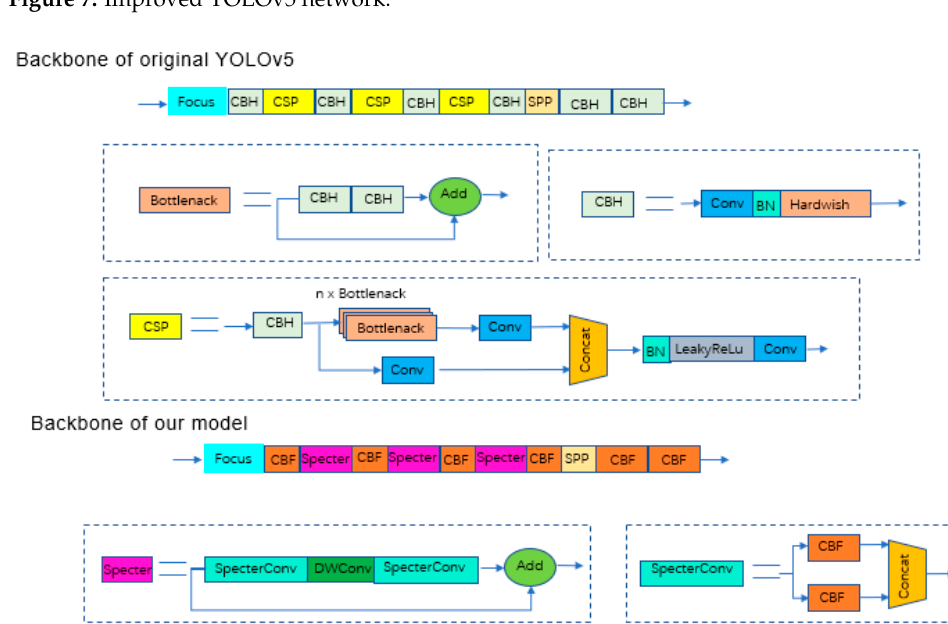
Figure 8. Backbone before and after improvement. The CBH module is composed of the Conv (con- volution), BN (batch normalization) and Hardwish activation